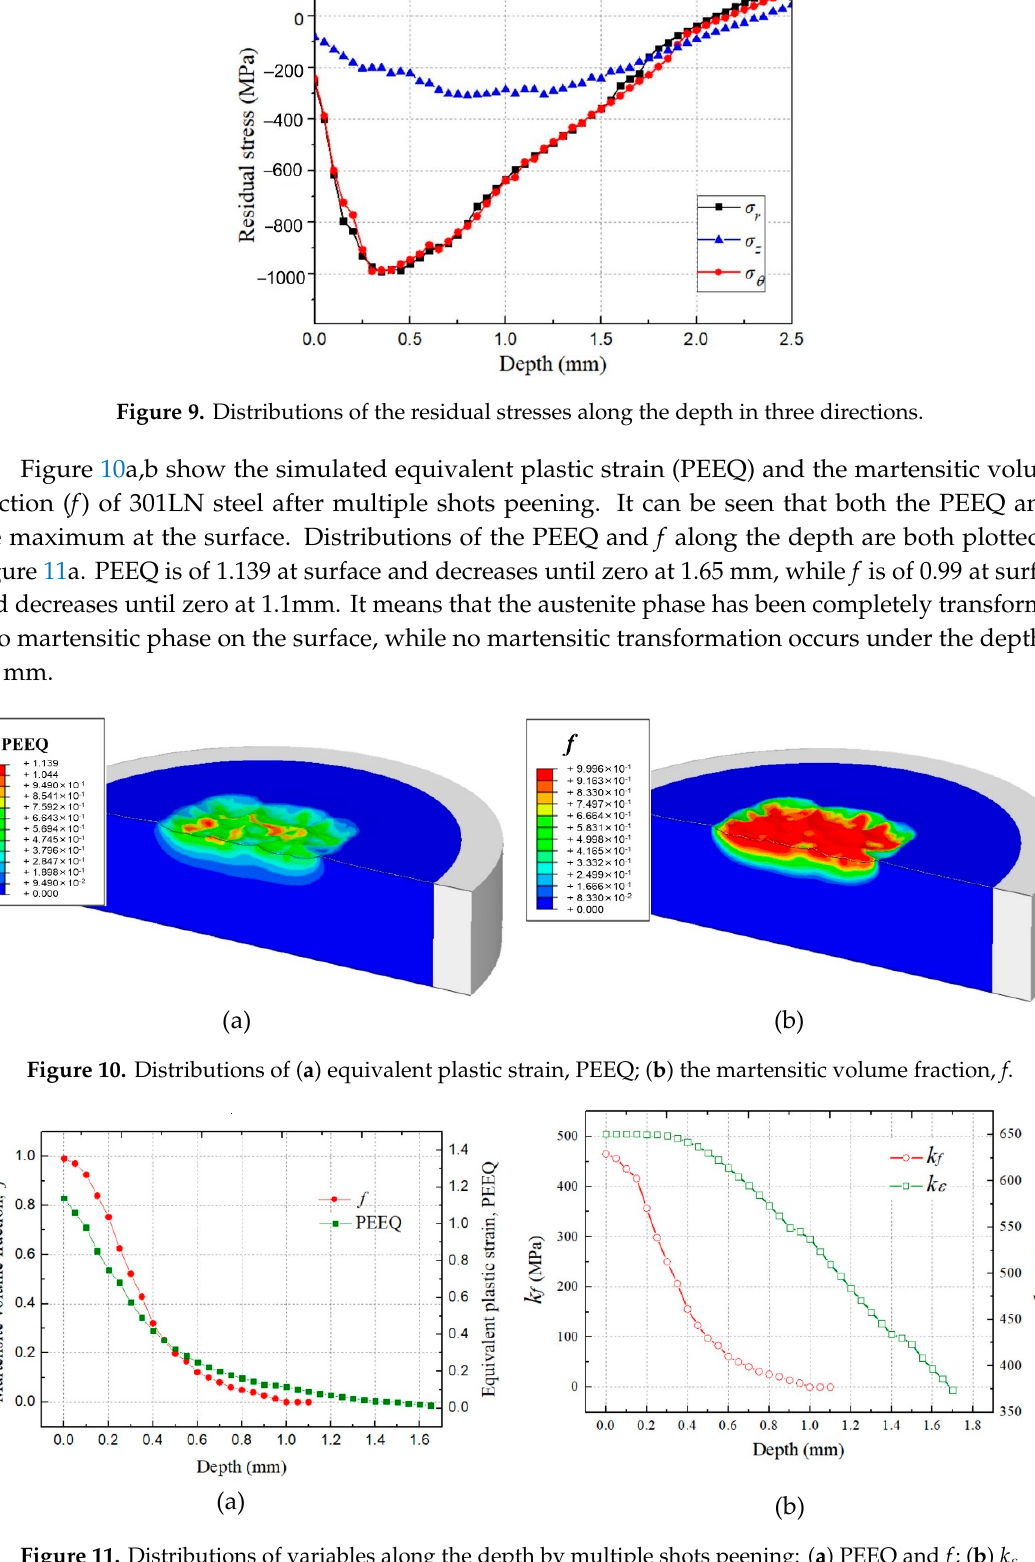
Figure 11. Distributions of variables along the depth by multiple shots peening: ( a ) PEEQ and f ; ( b ) k ε and k f